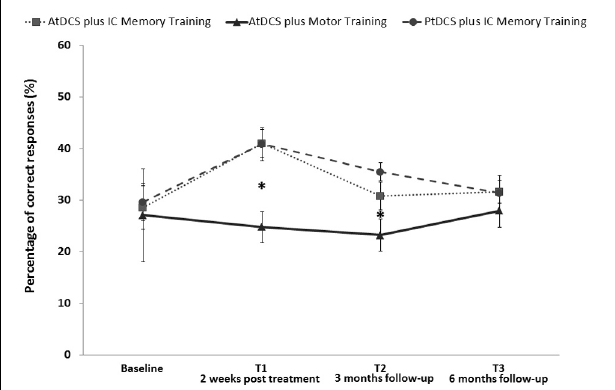
FIGURE 3 | Face-Name associations task (FNAT) memory accuracy (%) for treated stimuli at baseline (T0), after 2 weeks of treatment (T1) and 3 (T2) and 6 months (T3) after the beginning in AD patients who received AtDCS plus IC memory training, PtDCS plus IC memory training or AtDCS plus motor training ( ∗ p < 0 . 05). Error bars represent standard errors. Asterisks indicate the significant improvement in FNAT performance induced by AtDCS plus IC memory training and PtDCS plus IC memory training in comparison to AtDCS plus motor training at T1 and T2